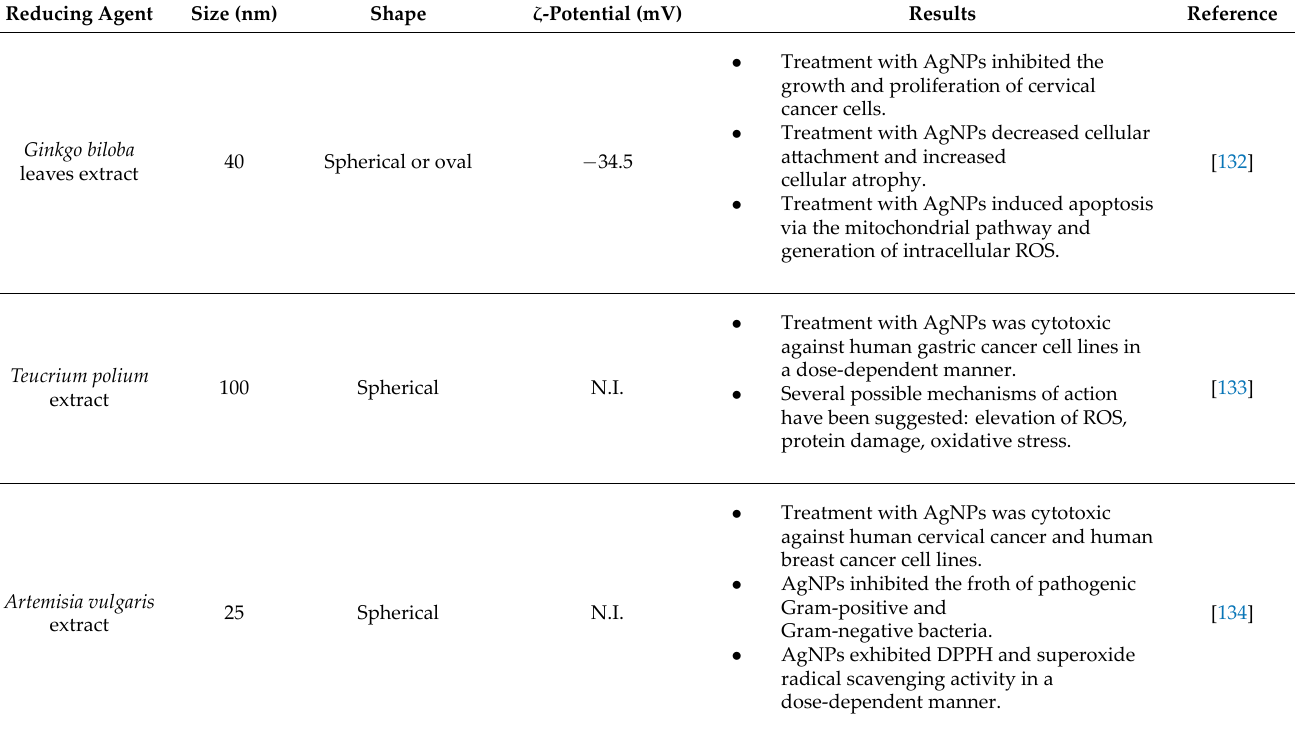
Table 2. Biosynthesized AgNPs with applications against cancer models.